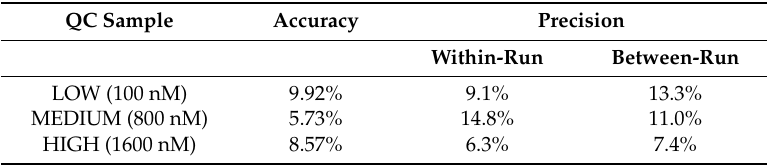
Table 1. Accuracy and precision evaluation (RSD %) of quality control (QC) samples.